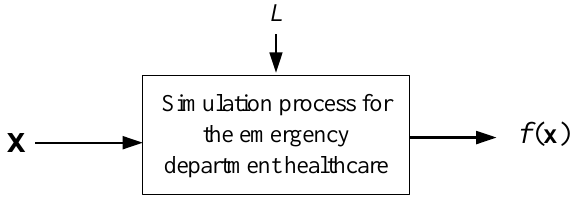
Figure 4. The input/output relationship of the emergency department healthcare.